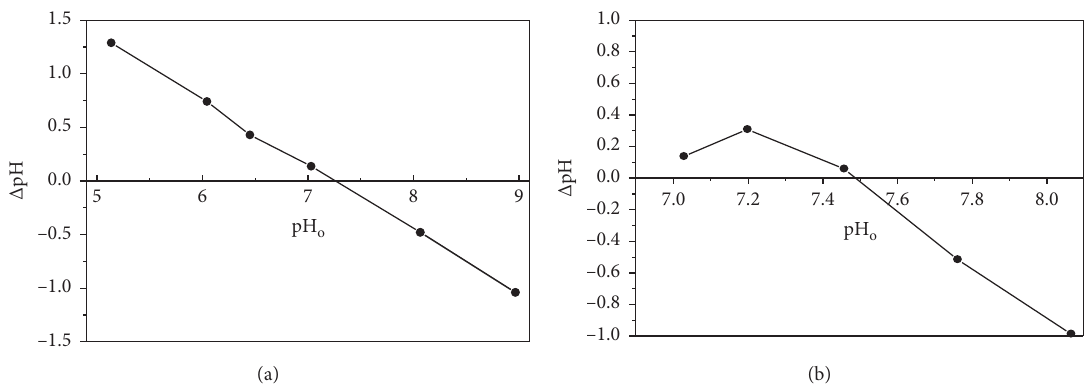
Figure 8: Graph for determining pH pzc of modified apatite in broad pH range (a) and in small pH range (b).